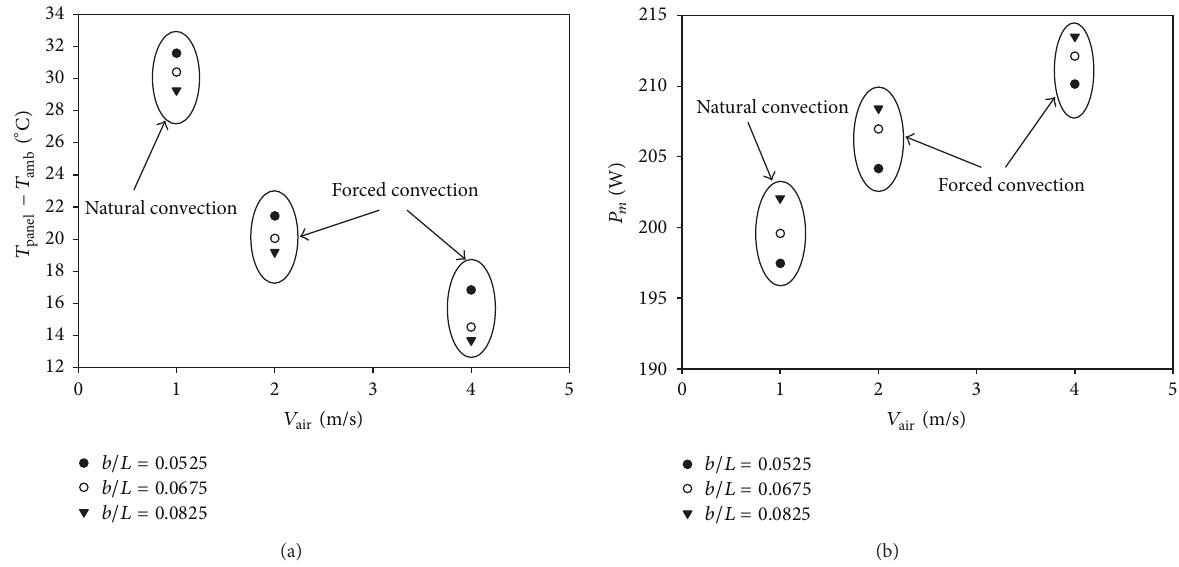
Figure 8: Comparison between natural and forced convection cases at different aspect ratios. (a) Peak power. (b) Temperature difference between the panel and ambient.